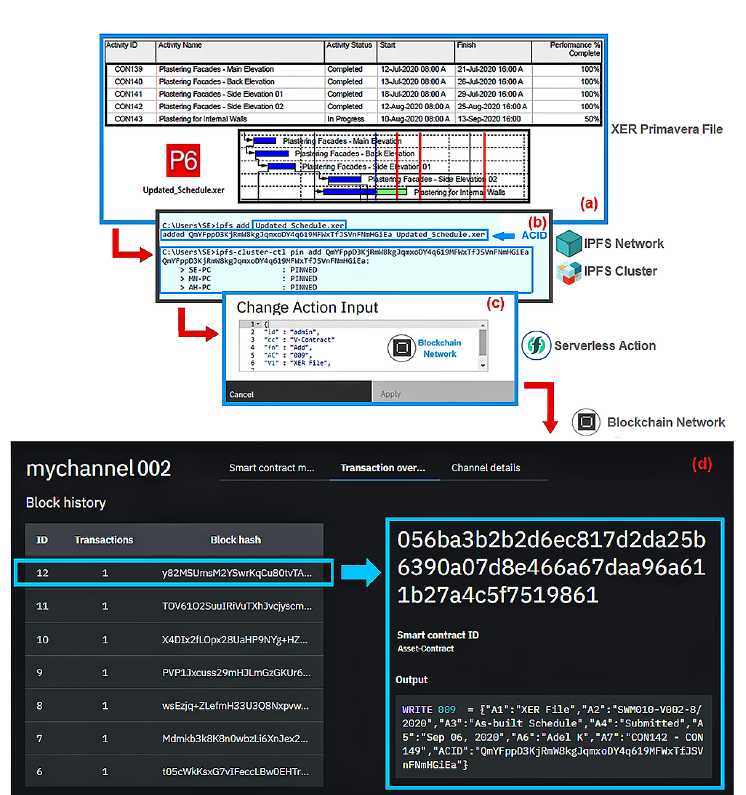
Figure 7. System testing